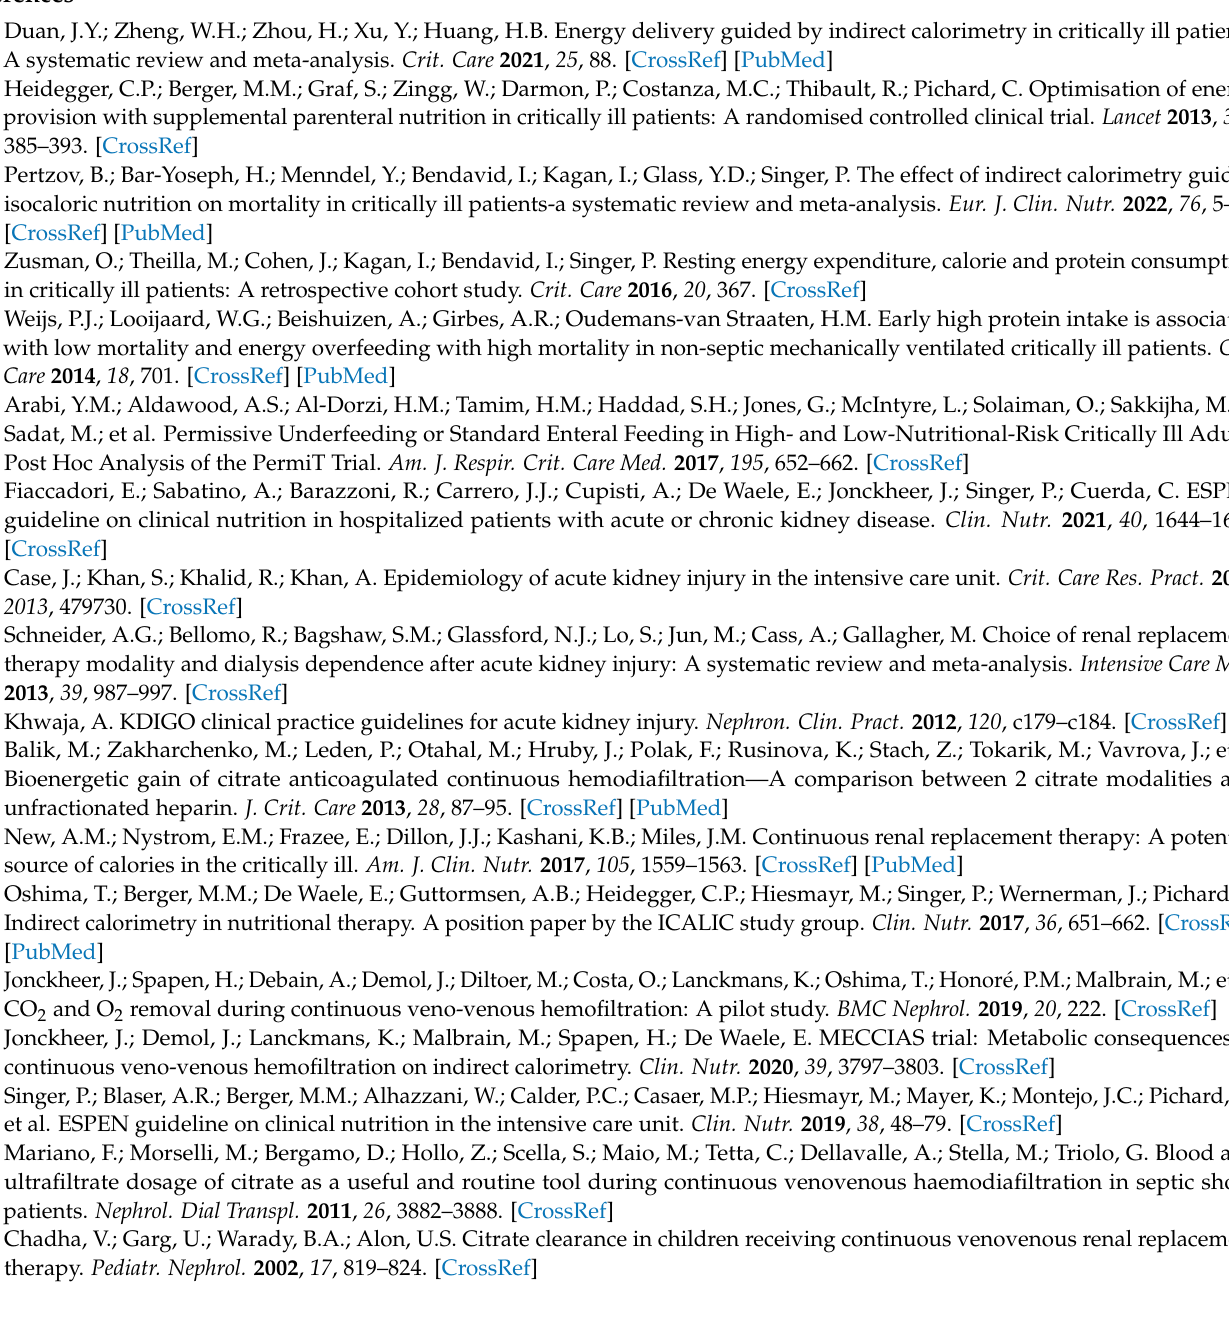
When data are presented as the mean, the standard deviation is also provided ( ±